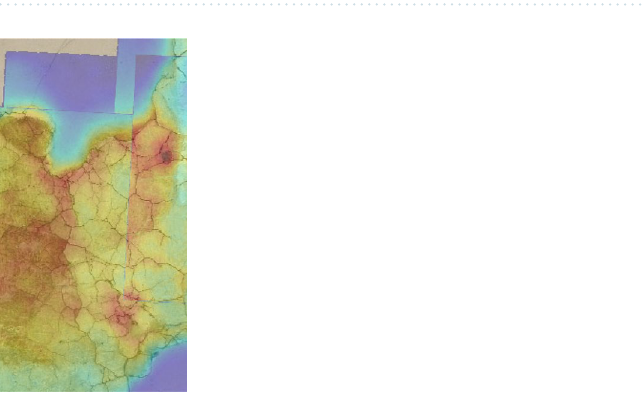
Figure 2. Radiometric mosaics of the TQR frames (left) and of the thermograms (right) registered to the visible, for the central part of the “Monocromo”, approximate dimensions 2.3 m at object plane. High reflectance regions on the lower right zone of the TQR mosaic revealed the presence of crystallised salts.